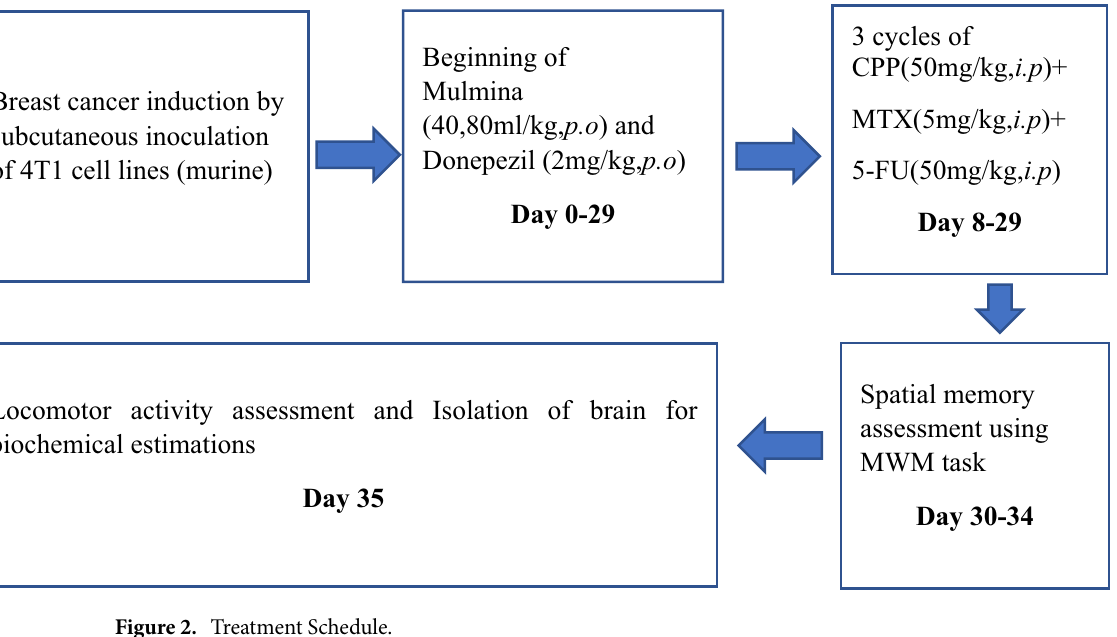
Figure 2. Treatment